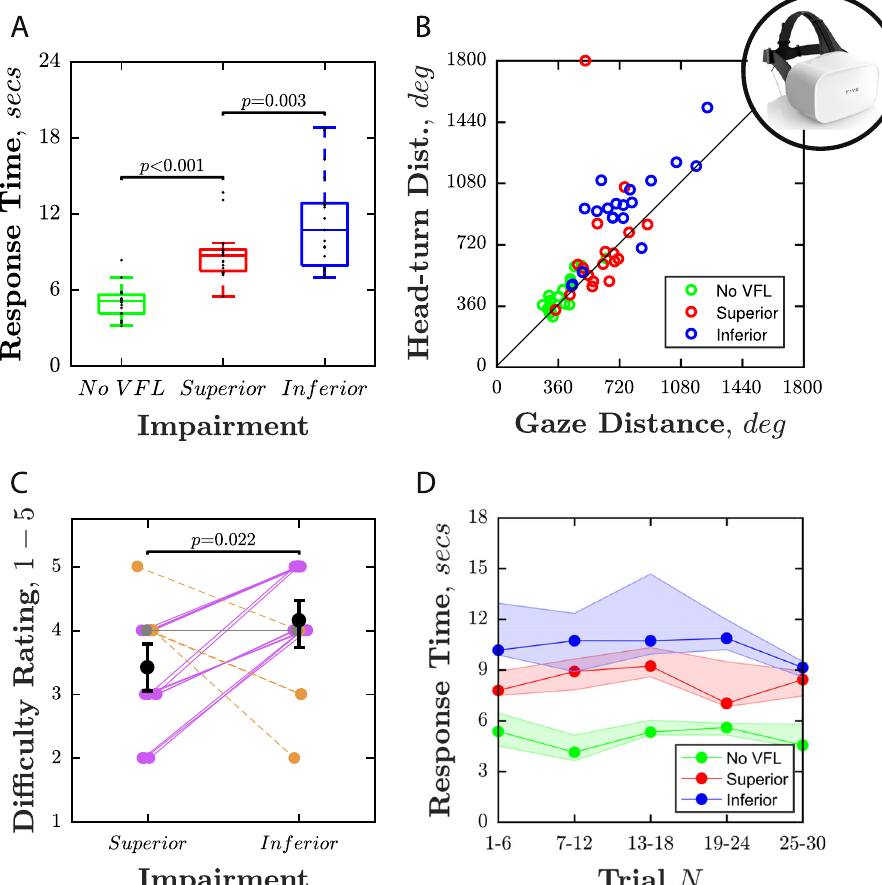
Fig. 4 Performance on VR search task. a Response time as a function of impairment type (box-and-whisker plots, showing median, interquartile range, and range). Black dots indicate individual participants. P values relate to Wilcoxon signed-rank tests (i.e., non-parametric repeated measures t -tests; see body text for statistics). b Scatter plot showing the cumulative distance traveled by each participant ’ s head and eyes in a single trial, averaged across all trials. Note the separation between each of the three conditions. c Self-reported dif fi culty ratings. Lines indicate individual participants, with those who rated the Inferior condition as more dif fi cult highlighted by purple solid line. Black bars indicate group-means and 95% con fi dence intervals (CI 95% ). d Group-median response times, ±CI 95% . These data are the same as those in panel A, but are here broken down into individual six-trial blocks to assess the consistency of the effect, and possible learning or Fig. 5, participants tended to fi xate around the midline in the No VFL condition, but fi xated consistently higher in the Inferior VFL condition ( z = 3.82, P < 0.001), and consistently lower in the